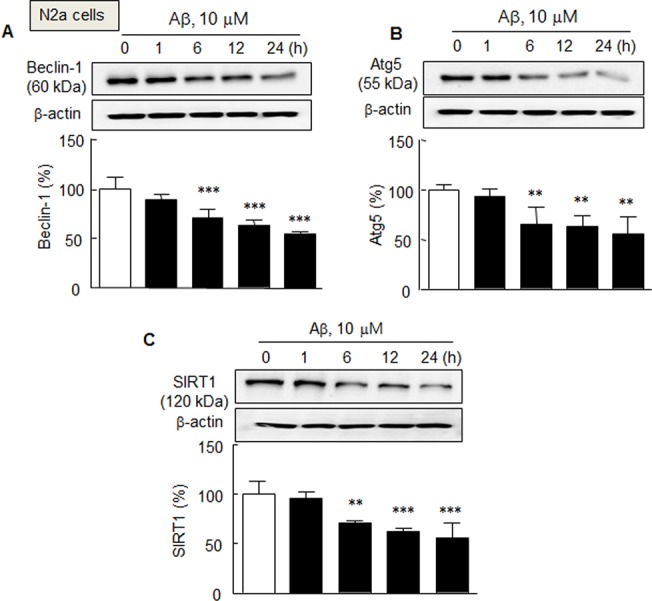
Time-dependent decreases in beclin-1 (A), Atg5 (B), and SIRT1 (C) protein expression in N2a cells exposed to exogenous Aβ1–42 (10μ μM).Means ± SDs are expressed as percentages of zero time values (N = 4). **P < 0.01, ***P < 0.001 vs. Zero time.